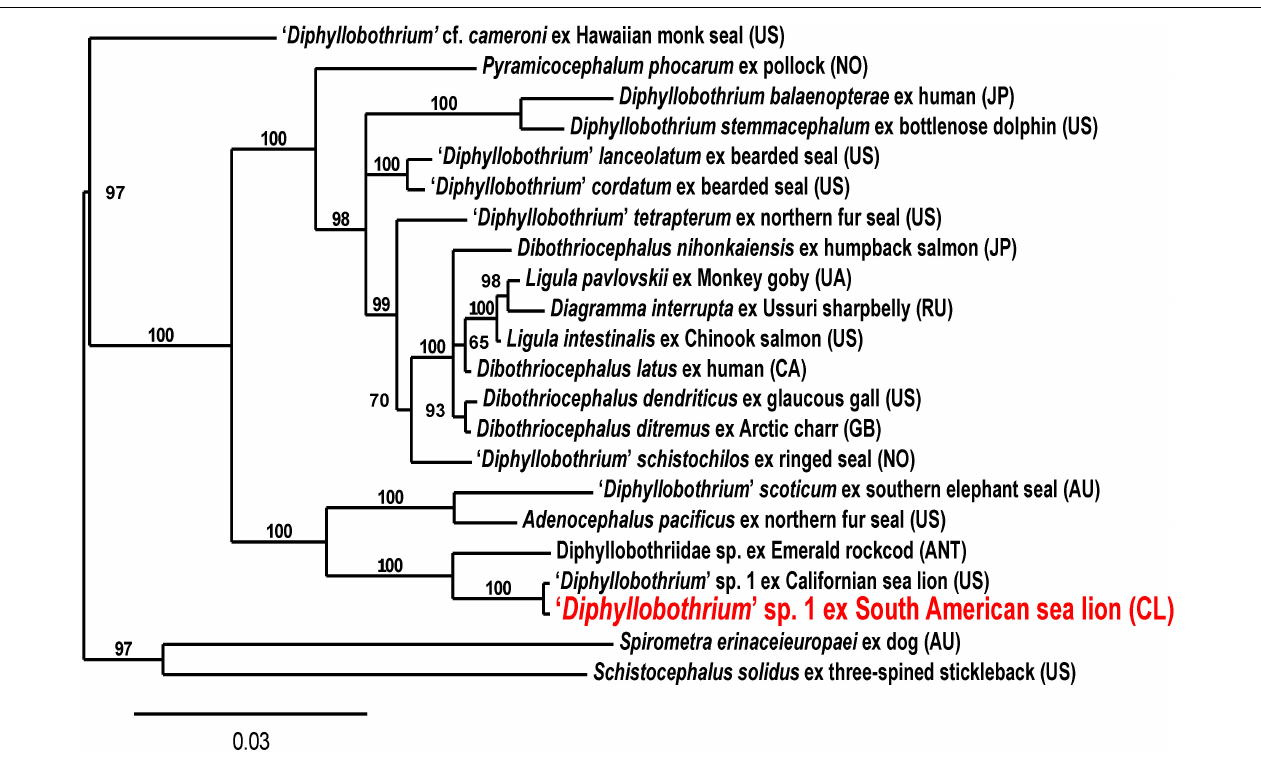
FIGURE 3 | Phylogenetic tree of “ Diphyllobothrium” sp. 1 from South American sea lions ( Otaria flavescens ) and related Diphyllobothriidae based on concatenated partial 18S and 28S rDNA regions using Bayesian analysis. Branch support as posterior probabilities in percent; scale bar: number of substitutions per site; host and country after the species name (Accession Nos. Supplementary Table S1